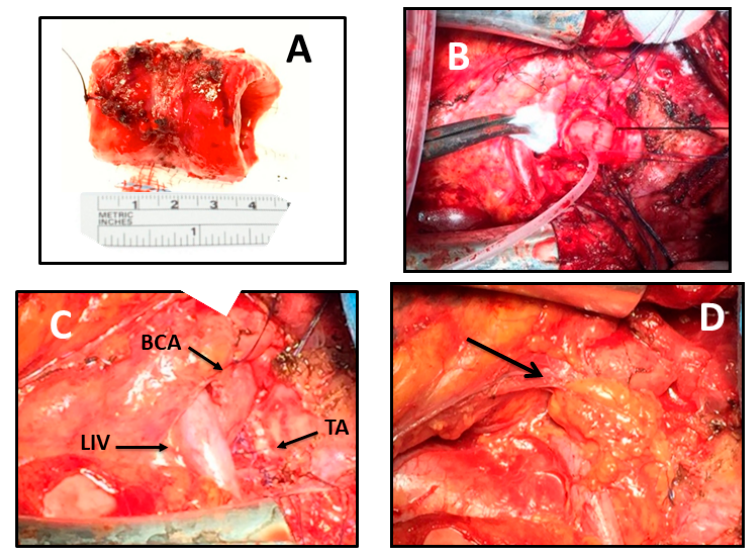
Figure 2. ( A ) The resected specimen measured 40 mm (5 tracheal cartilage rings) longitudinally. ( B ) Intraoperative view showing tracheal anastomosis performed under apnoeic hyperoxygenation. ( C ) Intraoperative view showing tracheal anastomosis (TA), left innominate vein (LIV) and brachiocephalic artery (BCA). ( D ) Suture line protected with reverse thymic fat pad interposed between the trachea and brachiocephalic vessels.